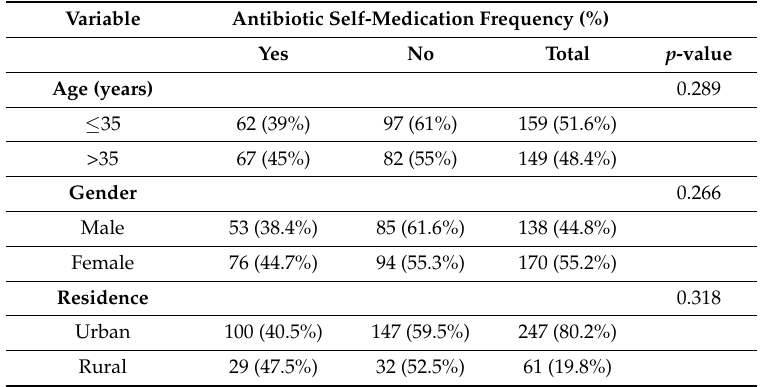
Table 3. Factors determining antibiotic